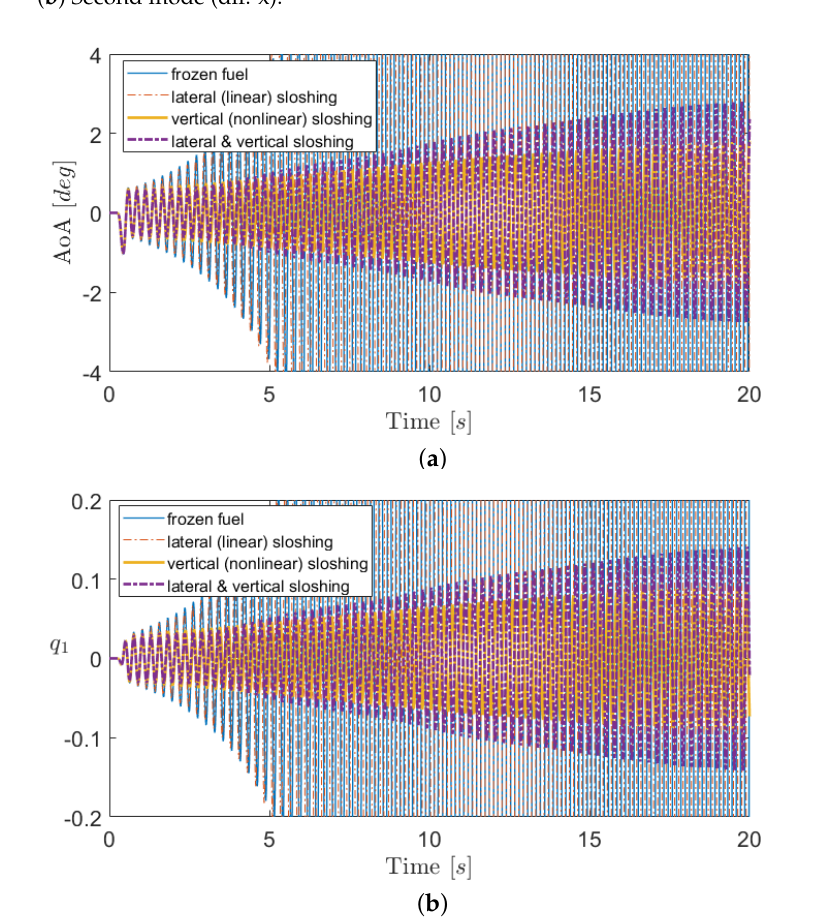
Figure 9. Sloshing modes for U ∞ = 18m/s and w g ( b ) Second mode (dir. x).